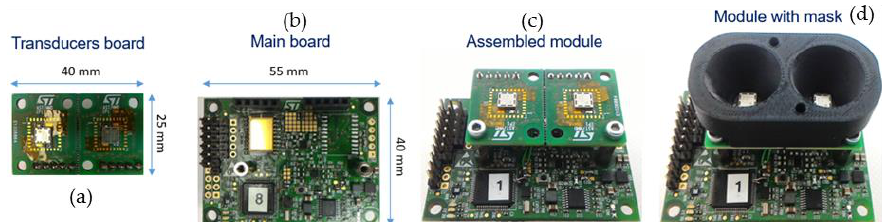
Figure 5. Ultrasound module components: ( a ) transducer board; ( b ) main board; ( c ) ultrasound module; ( d ) ultrasound module with cone-shaped mask.